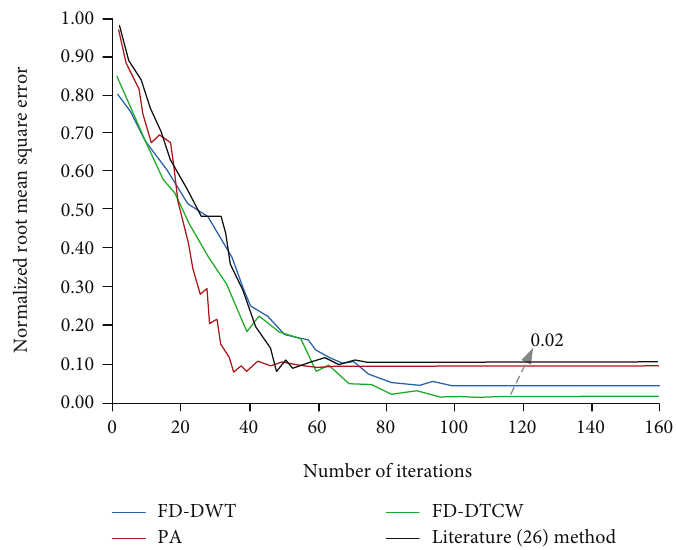
Figure 7: Variation of the root mean square error of each model during the training process.